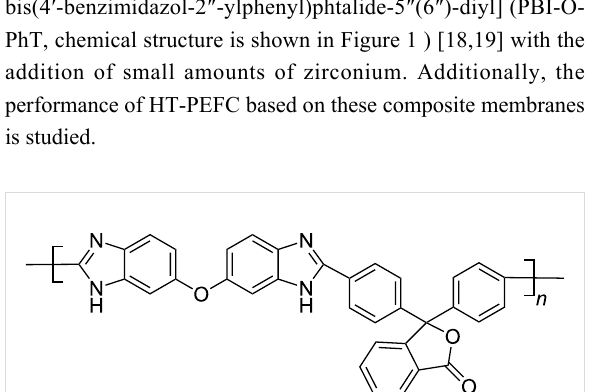
Experimental Membrane preparation PBI-O-PhT synthesis Initially, 3,3',4,4'-tetraaminodiphenyl ether (0.461 g, 2